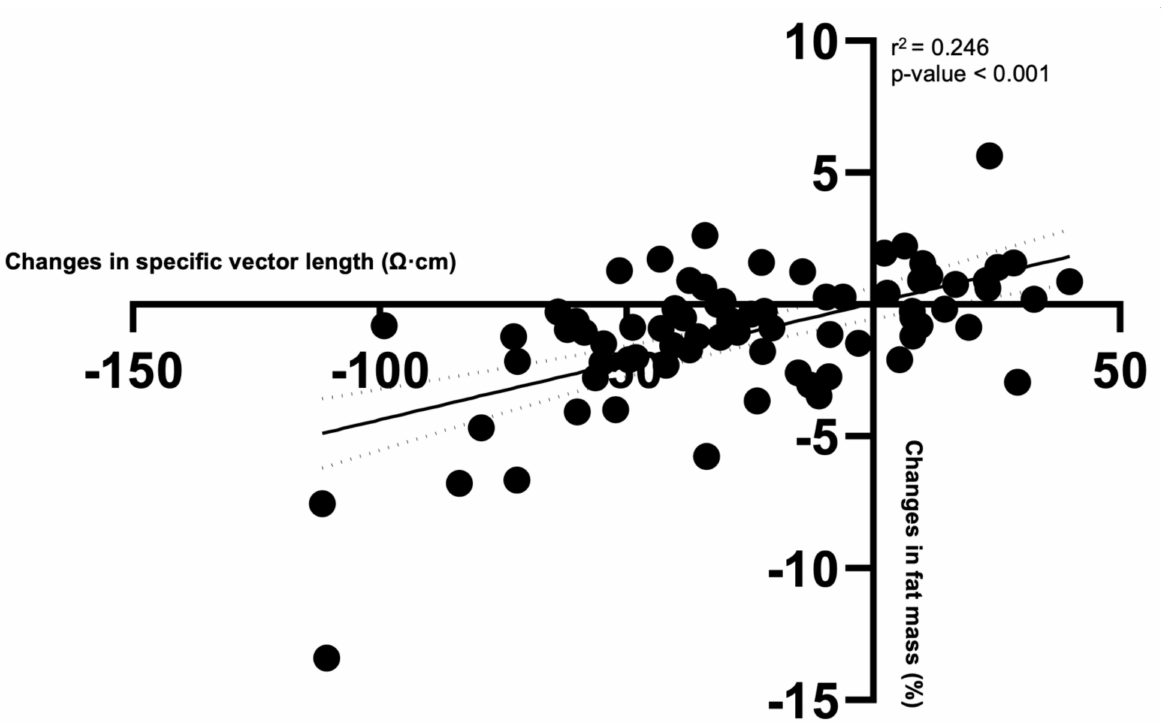
Figure 2. Scatter plot with changes in specific vector length and percentage of fat mass considering all participants as a whole